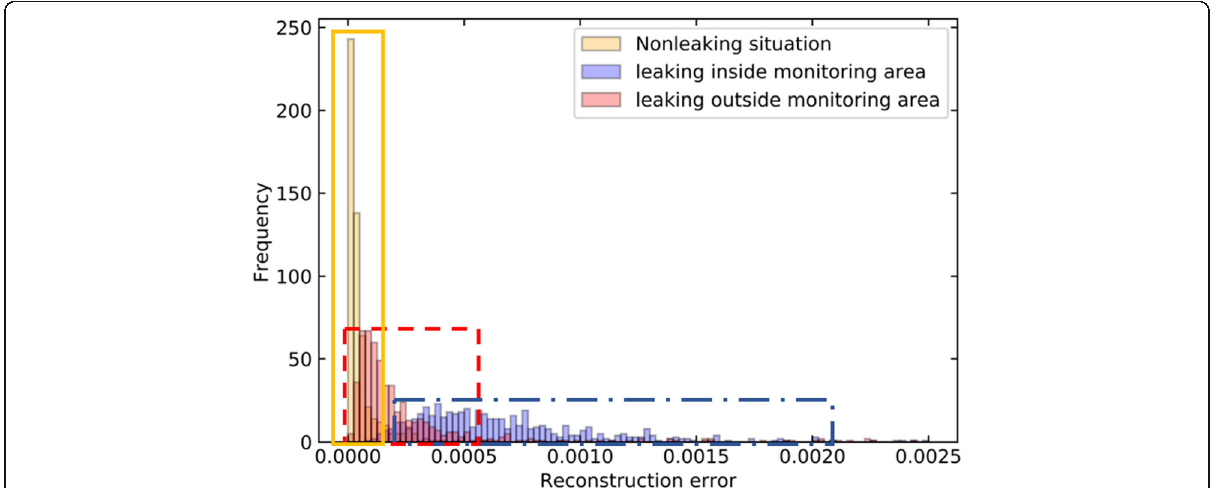
Fig. 10 Reconstruction error by AE model for data under normal non-leaking condition versus leaking situation (including leaks inside and outside the monitoring